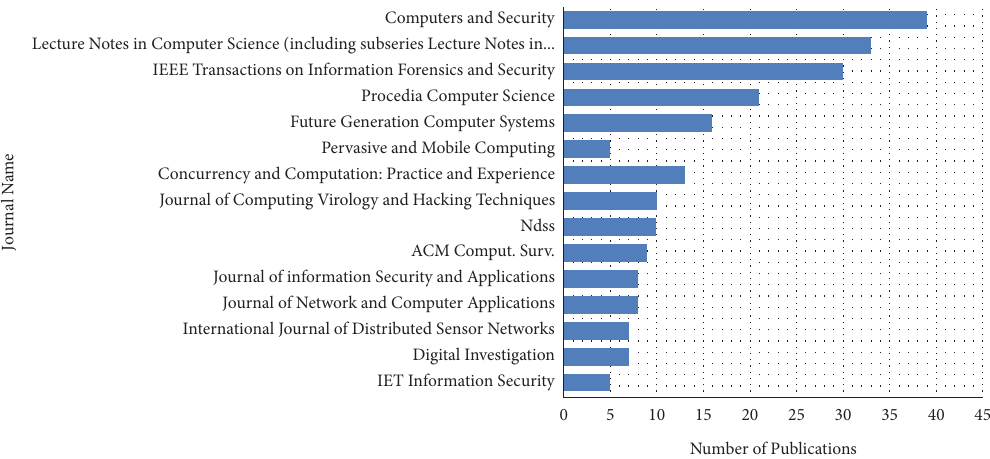
Figure 8: Top journals focusing on Android security